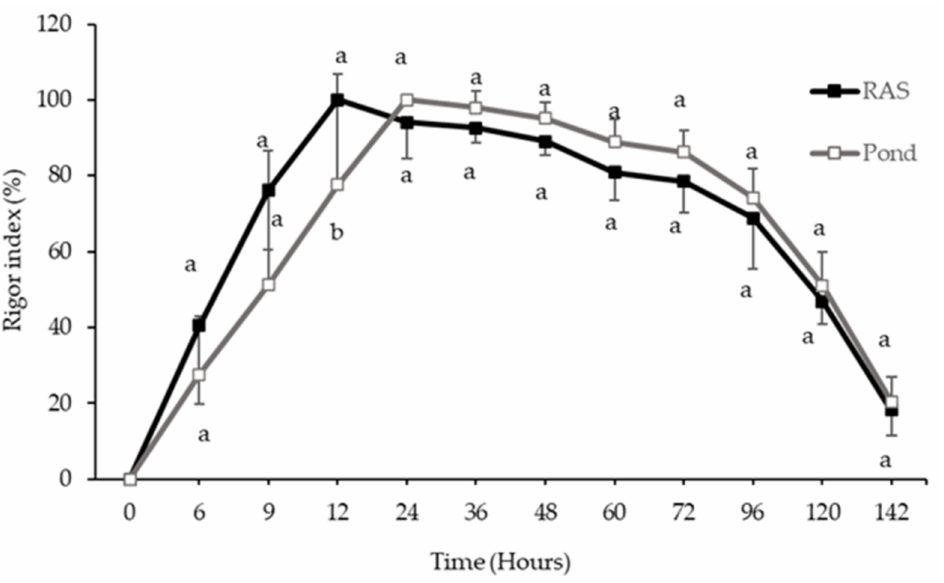
Figure 1. Changes of rigor index of perch from recirculating aquaculture systems (RAS) and pond during 140 h refrigerated storage at +4 ◦ C. Different small superscript letters on the line indicate significant difference ( p < 0.05) between rearing systems at the same time point (mean ± S.D., n =